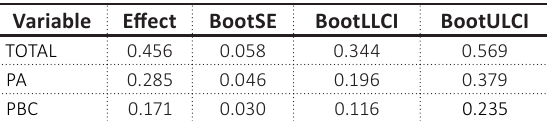
Table 4. Indirect effect of emancipation on entrepreneurial intention